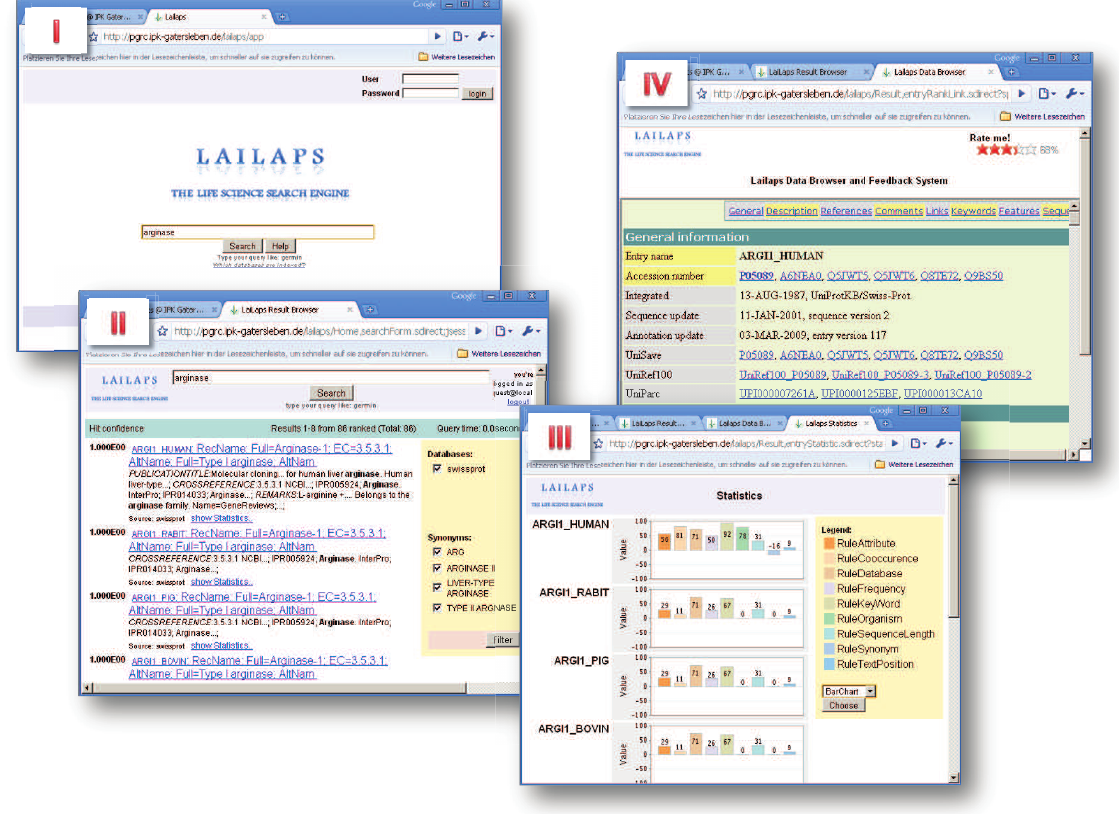
Figure 4: LAILAPS view of an example query session – The four browser windows represent the common query workflow of LAILAPS. Start screen with an optional login to load a customized ranking profile (I). The query might be specified as a single word, combination of words delimited by a whitespace or quoted phrases. The ranked query result is presented as a list of relevance sorted database accessions (II), with a short hit description, the evidence value, the hyper link to the original data source and a link to the scoring statistics in window (III). The exploration of hits is supported by a detail browser and feedback system (IV). The original data is displayed and the user might rank the relevance of the hit for later training of the user ranking